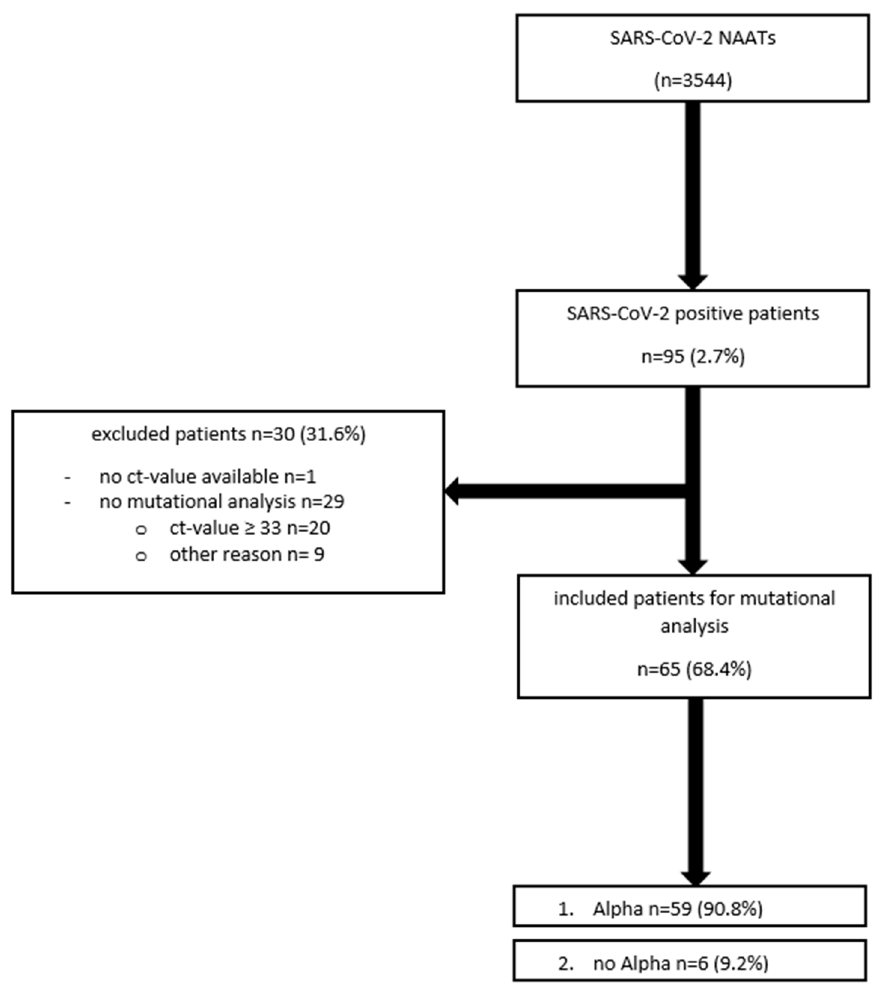
Figure 1. Distribution of patient population ( n = 3544 nucleic acid amplification tests (NAATs); 12 January 2021–3 June 2021).